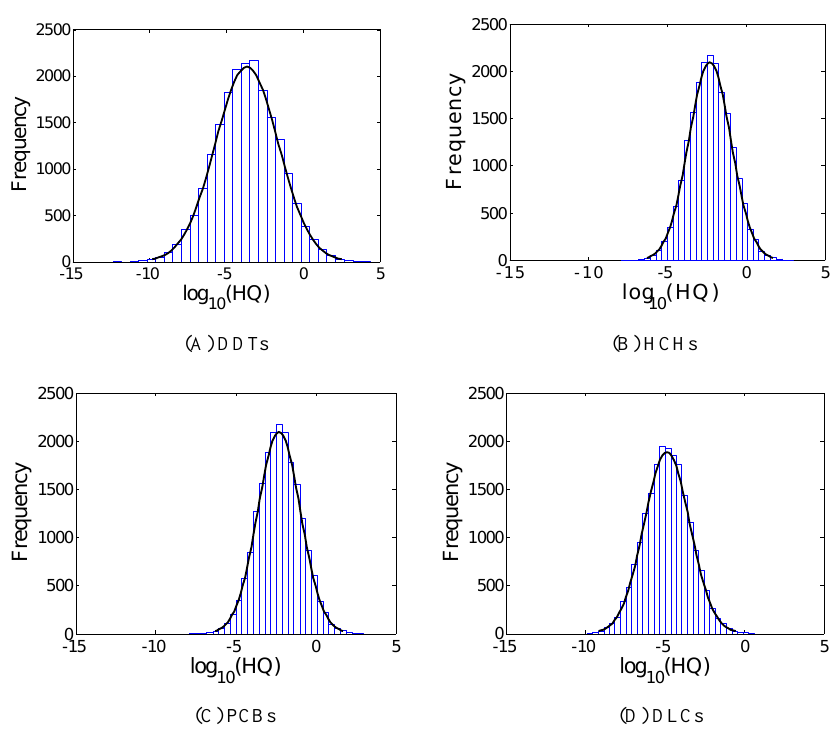
FIGURE 2. Combined HQ distributions of DDTs, HCHs, PCBs, and DLCs in the Haihe River.